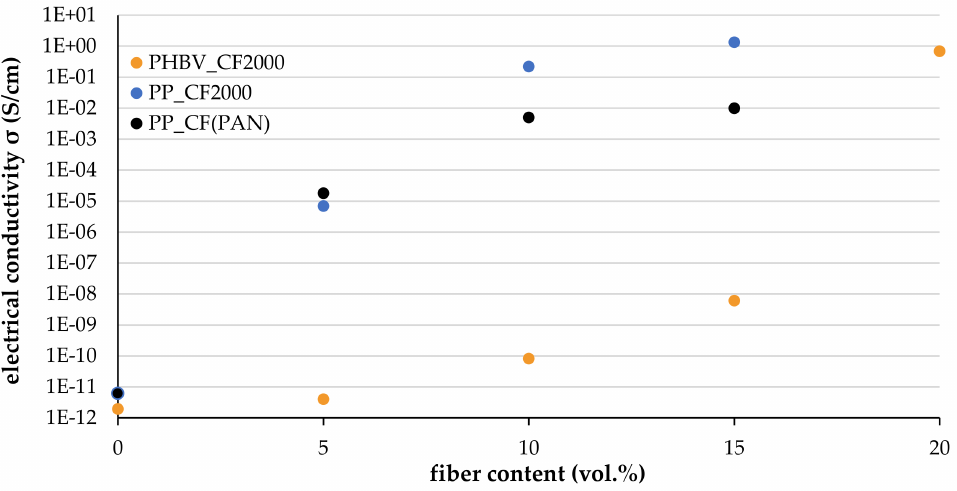
Figure 5. Electrical conductivity (at 50 Hz) of PHBV/CF and PP/CF composites. Determination of percolation threshold. L/D is approximately 12 for PHBV_CF2000, 19 for PP_CF2000 and 50 for PP_CF(PAN)